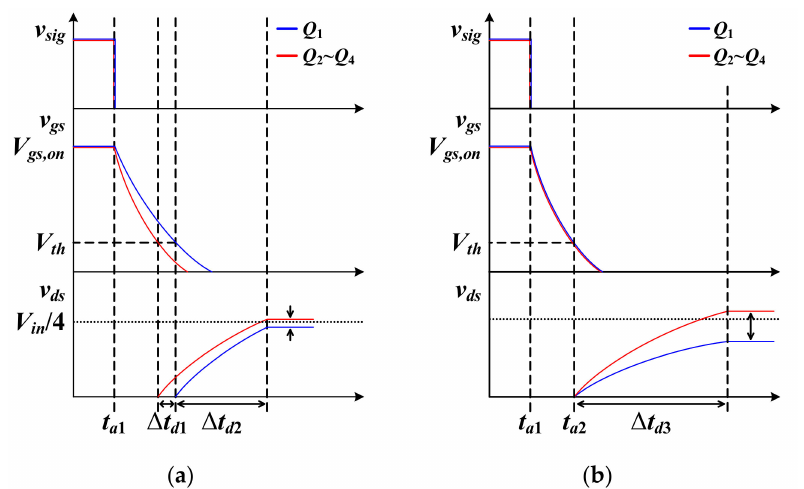
Figure 7. Turn-o ff switching waveforms: ( a ) with di ff erent input capacitances C iss ; ( b ) with di ff erent output capacitances C oss